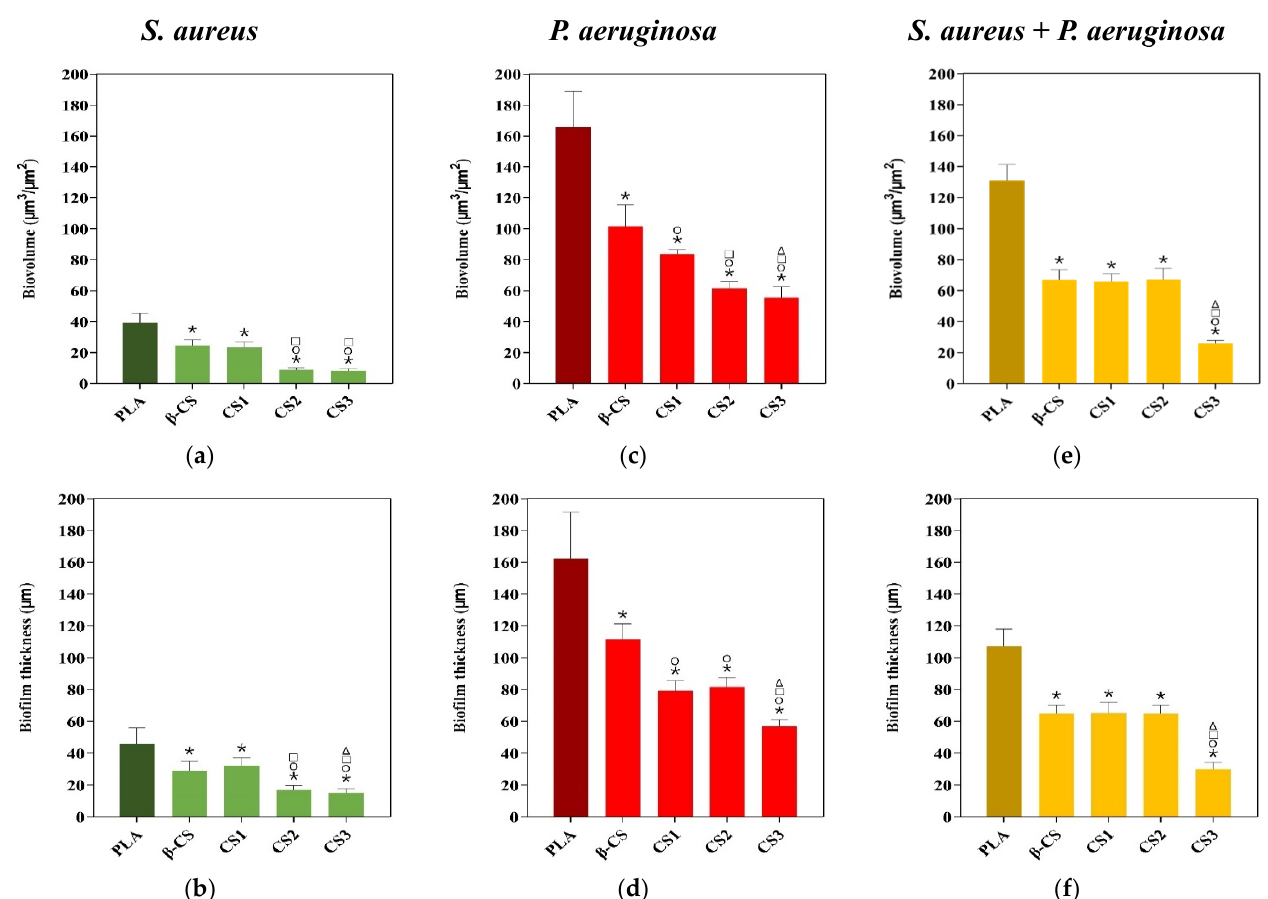
Figure 4. Biovolumes ( a , c , e ) and thickness ( b , d , f ) of S. aureus and P. aeruginosa single-species biofilms, and of dual-species biofilms ( S. aureus + P. aeruginosa ) on PLA and CS-coated PLA surfaces. These parameters were obtained from confocal image series using the COMSTAT2 tool associated with the ImageJ software. The means ± standard deviations for three independent experiments are illustrated. Statistical analysis was performed using one-way analysis of variance (ANOVA) and significant differences were represented for p -values < 0.05 by *, ○ , □ , and Δ when compared with PLA, β -CS, CS1, and CS2, respectively.